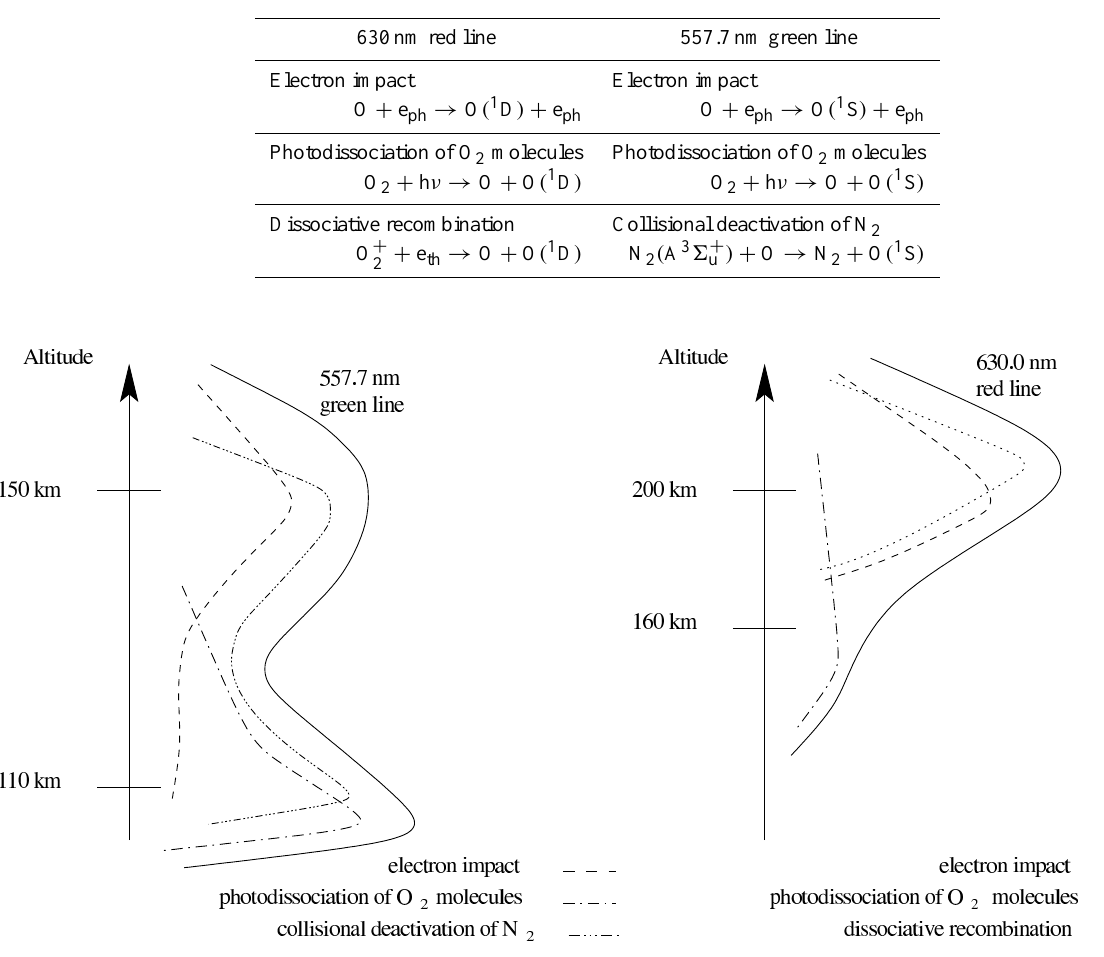
Fig. 2. Relative contributions of processes involved in the green (left-hand side) and red (right-hand side) atomic oxygen day time emissions (after Witasse et al., 1999). This scheme stands for solar conditions with f 10 . 7 ∼ 120, low magnetic activity ( A p < 10) and at